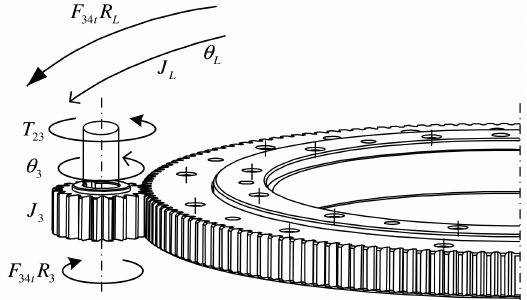
Figure 7. Pinion and LGR coupling.